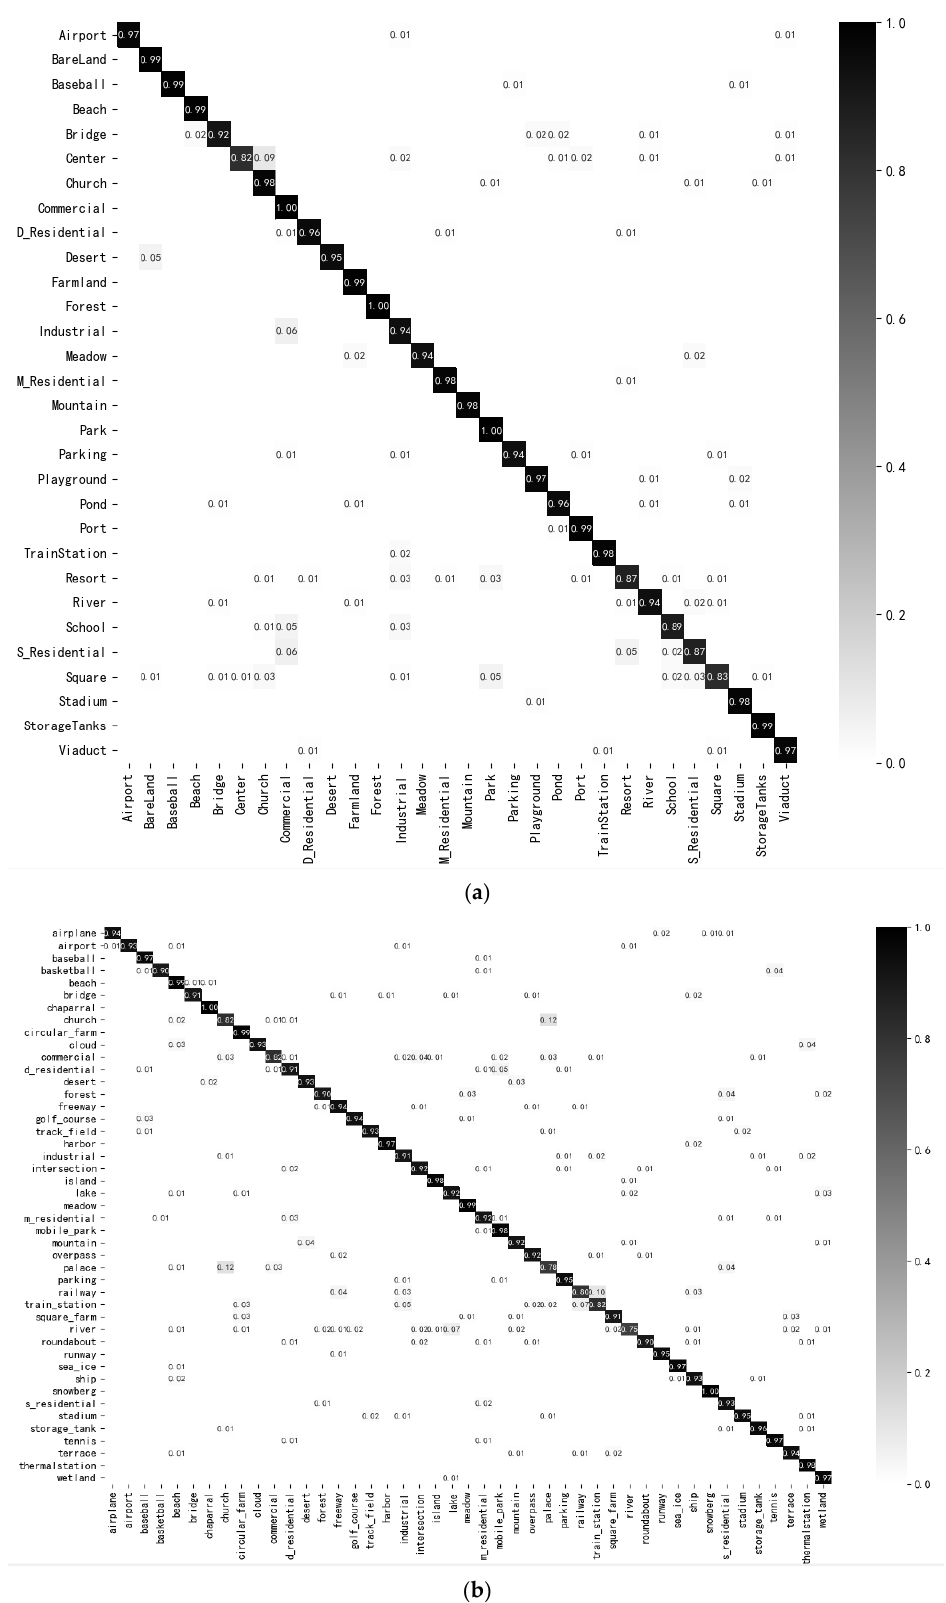
Figure 6. Confusion matrices of BMDF-LCNN method proposed on 20/80 AID and 10/90 NWPU datasets. ( a ) Confusion Matrix on 20/80AID Dataset. ( b ) Confusion Matrix on 10/90NWPU